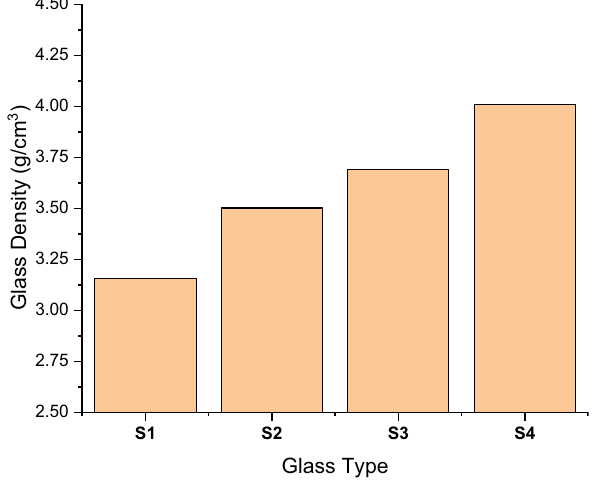
Figure 5: Variation of investigated glass